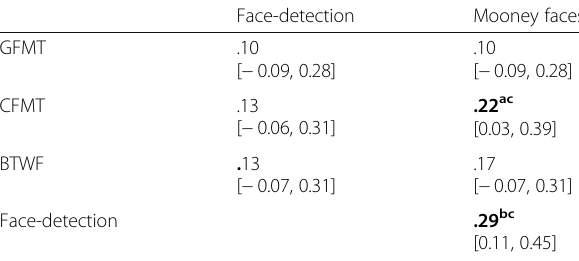
Table 3 Correlations between performance on the additional face-processing tasks (Face-detection and Mooney faces) and face-identity tasks (Glasgow Face Matching Test (GFMT), Cambridge Face Memory Test (CFMT), Before They Were Famous task (BTWF)) used in Study 2. Uncorrected significant correlations are shown in bold: a p < .05, b p < .01; c Significant correlations following Benjamini-Hochberg correction; 95% CI shown in